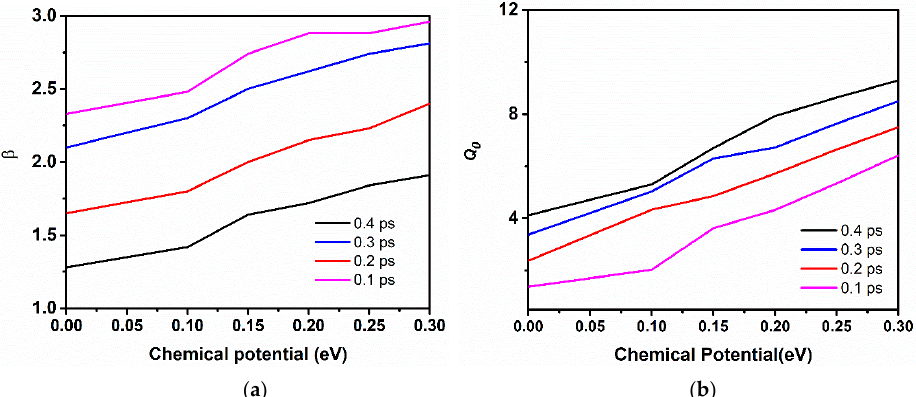
Figure 19. ( a ) Coupling coefficient behavior with increasing relaxation time; and, ( b ) Corresponding quality factor response with different relaxation times. Table 2. Performance comparison of the results with respect to the equivalent circuit model.